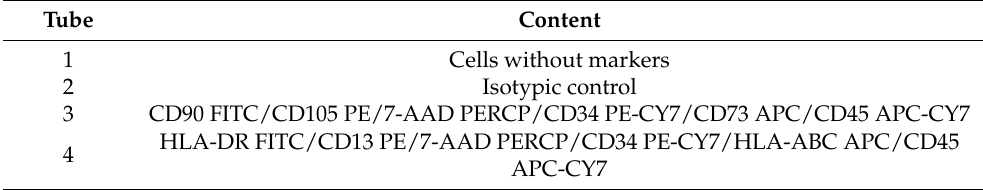
Table 1. Cytometry panel. Tube